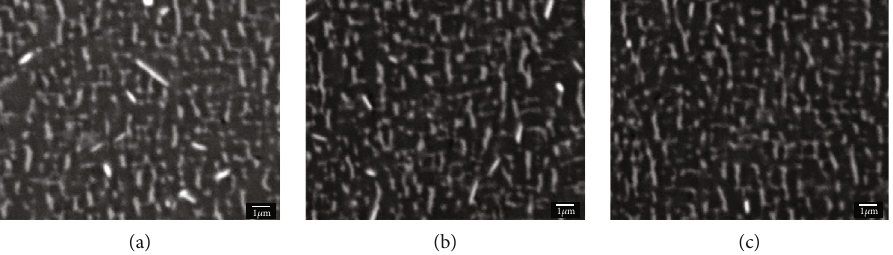
Figure 2: Microstructure of single crystal alloy IC6SX after creep at 980 ° C: (a) 180 MPa, 245.5h; (b) 205 MPa, 121.47h; (c) 230MPa, 69.3h.